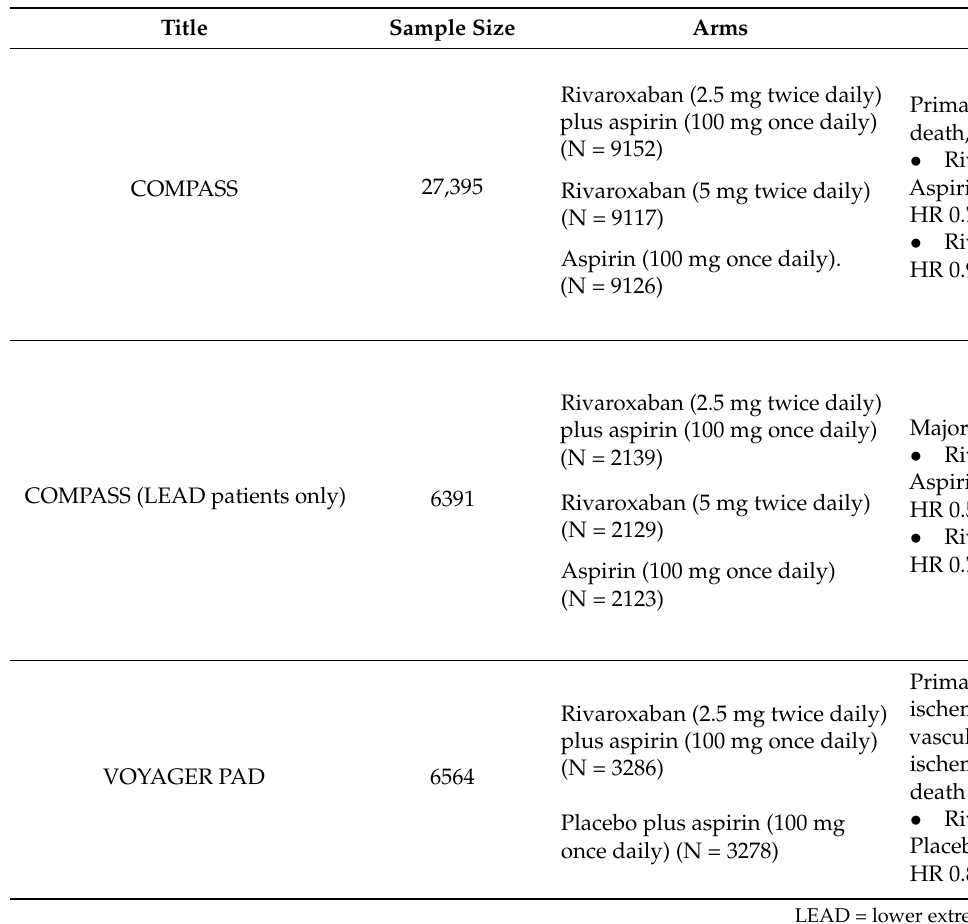
Table 1. Summary of results from randomized clinical trials using rivaroxaban in the context of peripheral artery